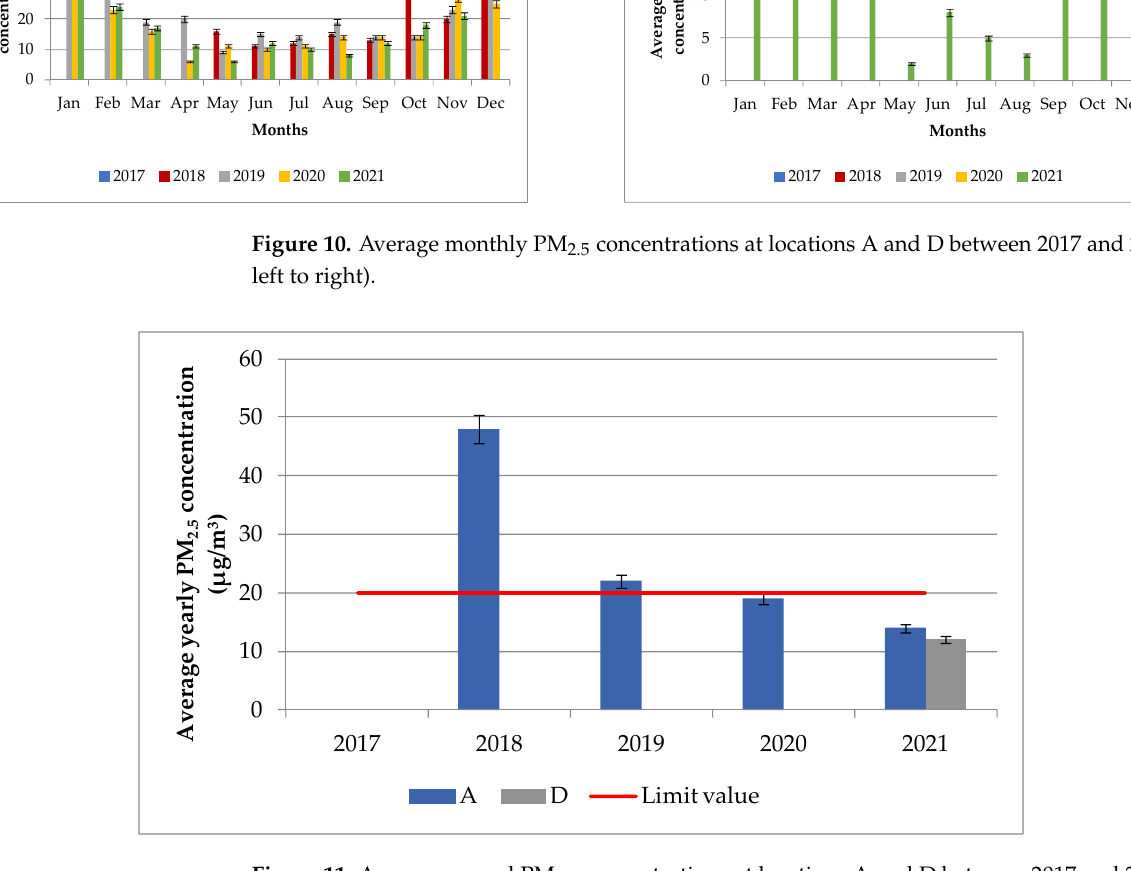
Figure 11. Average annual PM 2 . 5 concentrations at locations A and D between 2017 and 2021. To sum up, concentration levels of PM 10 and PM 2.5 were higher during the cold period of the year compared to spring and summer seasons. The difference between au- tumn/winter and spring/summer concentration levels has been calculated to be around 15%. The concentration levels of PM 10 and PM 2.5 between 2018 and 2020 were already stud- values were negligible. The year 2021 was still marked with the COVID-19 pandemic, and thus obtained values may be affected by it. It was similarly found in other works